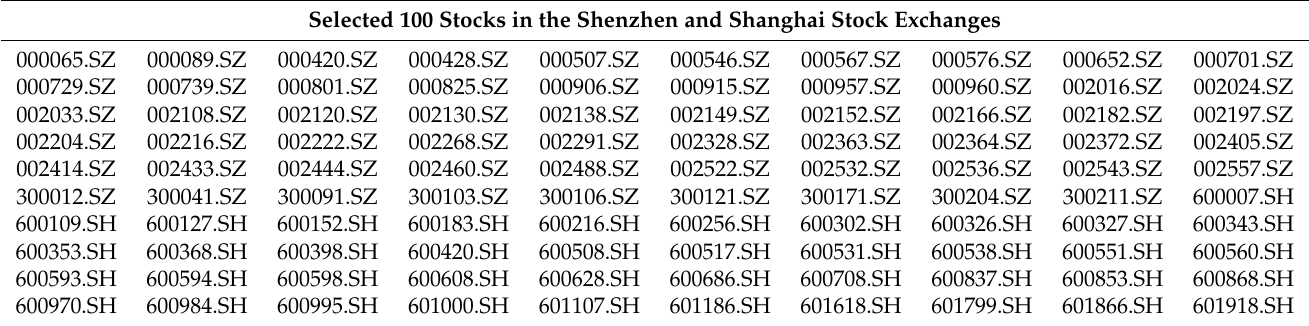
Table A1. Ticker symbol for the 100 randomly selected stocks in the Shenzhen and Shanghai stock exchanges. The suffix “.SZ” denotes Shenzhen and the suffix “.SH” denotes Shanghai.